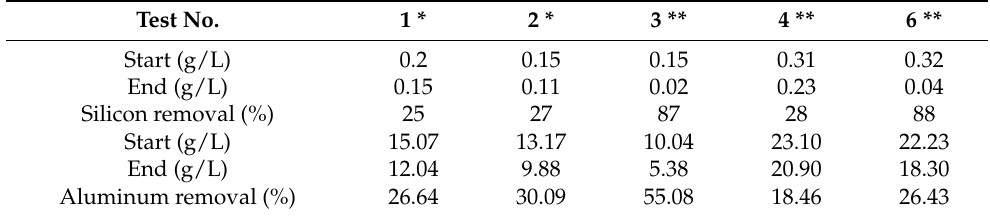
Table 8. Concentration of Si and Al in solution measured by ICP-MS and precentage removal of Si and Al from solution .